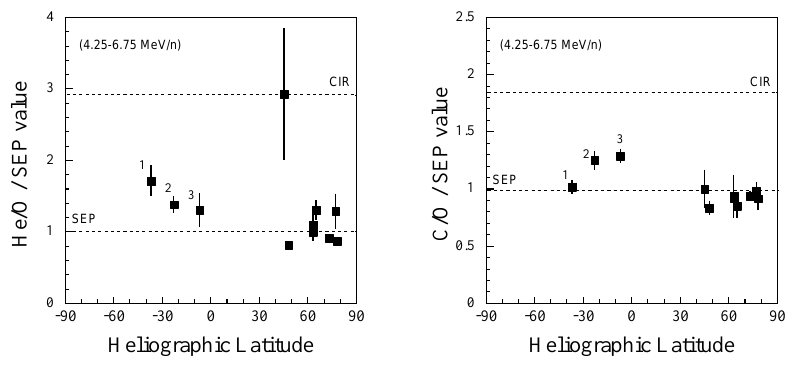
Fig. 6. Elemental abundance ratios He/O and C/O with respect to the corresponding reference values (Mason and Sanderson, 1999) averaged dur- ing eleven selected time periods from the solar polar passages in 2000 / 2001 to May in 2002 as a function of the helio-latitude. The elemental com- position measurements were made